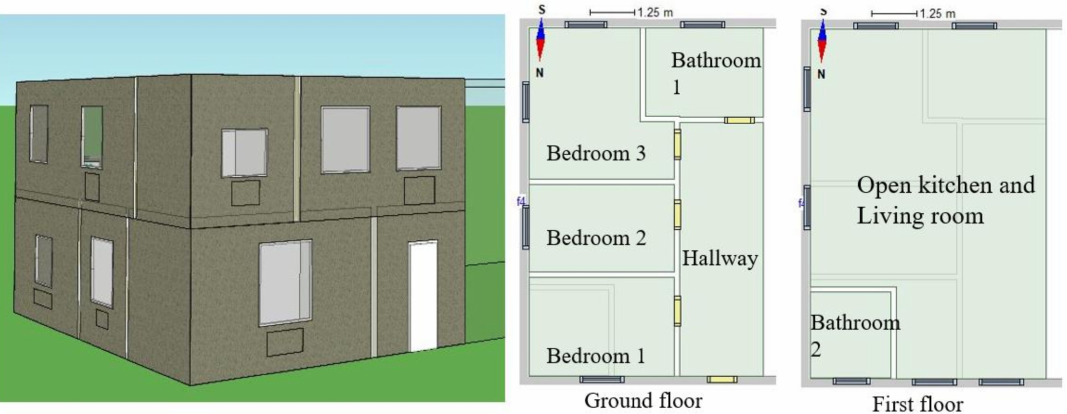
Figure 3. The reference residential building model in IDA